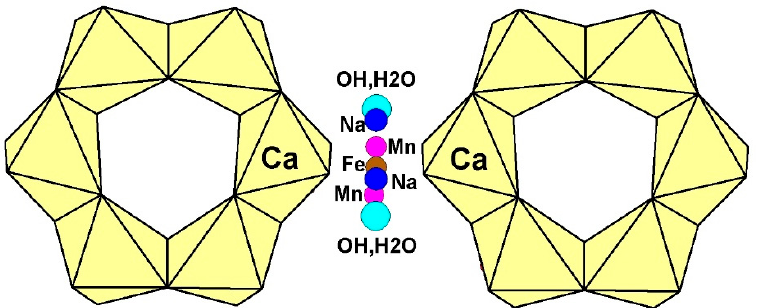
Figure 4. Cation distribution over M 2 sites between CaO 6 octahedra in Sample 4 (Table 4) [29].